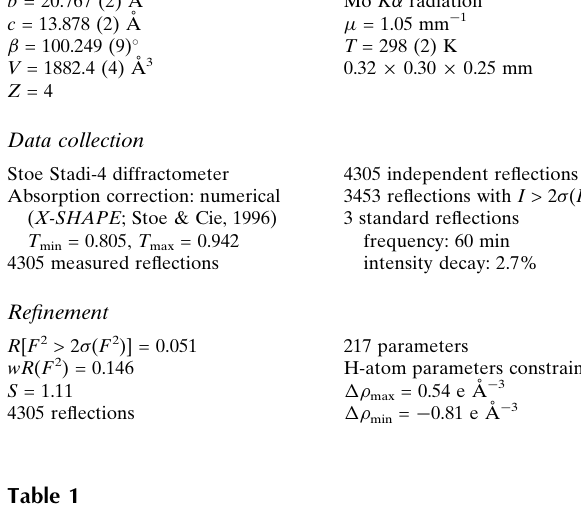
Hydrogen-bond geometry (A˚ , (cid:2)